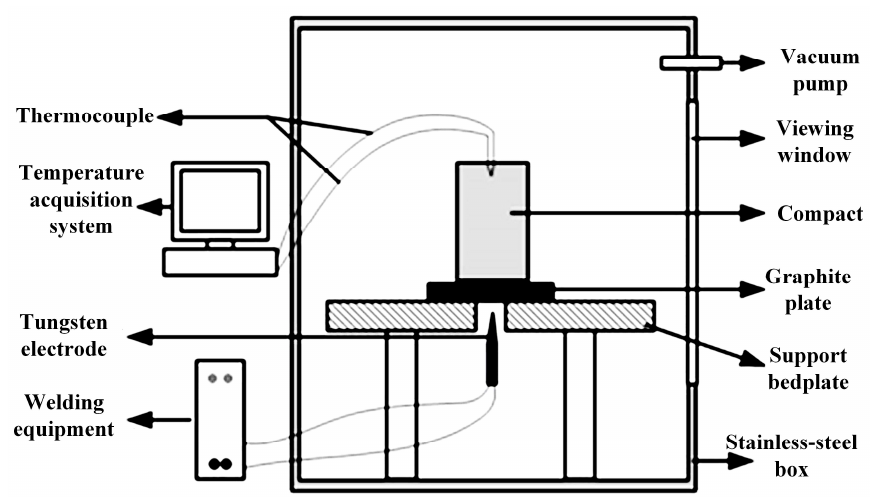
Figure 2. Self-propagating high-temperature synthesis (SHS) experimental device schematic.